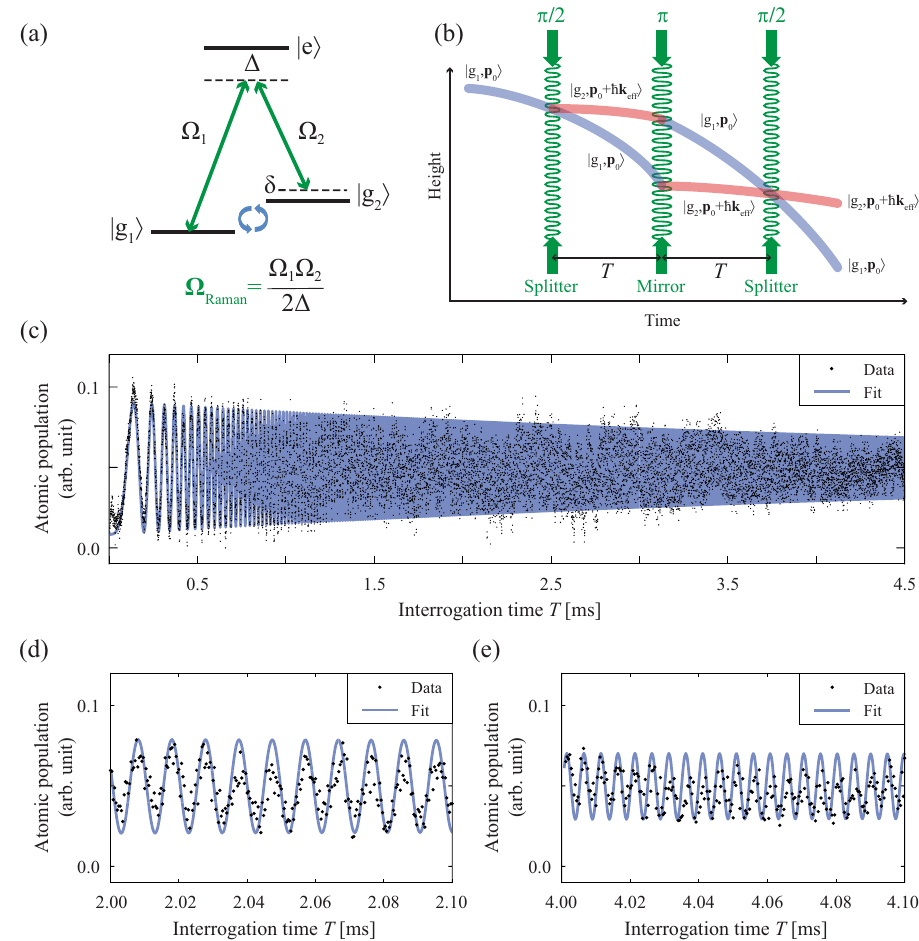
Fig. 8 Atom interferometry of sub-Doppler cooled GMOT atoms in the compact LPAI sensor head. a Three-level atomic system for stimulated Raman (cid:1) (cid:1) (cid:1) (cid:1) (cid:3) (cid:3) (cid:3) (cid:3) (cid:1) (cid:1) (cid:1) (cid:1) ¼ 0 ¼ 0 ¼ F ¼ 1 ; m ¼ F ¼ 2 ; m transitions. g 1 , ground state 1; g 2 ground state 2; e j i , excited state; Δ , single-photon detuning; δ , two-photon (cid:1) (cid:3) F F (cid:1) ! e j i transition; detuning which depends on the Doppler shift; Ω Raman , effective Rabi frequency of Raman beams; Ω 1 , single-photon Rabi frequency of g 1 (cid:1) (cid:3) (cid:1) Ω ! e j i transition. b Space-time trajectory of atomic wavepackets during LPAI. A three-light-pulse sequence, 2 , single-photon Rabi frequency of g 2 π the initial atomic momentum; T , the free-evolution time between Raman pulses; k eff , the effective wavenumber of stimulated Raman transition; k , the wavenumber (2 π / λ ) of a single Raman beam. c Scan of the interrogation time showing the LPAI chirped fringe for T = 0.0 ms to 4.5 ms. The fringe chirping results from the Doppler shift of the cold atoms relative to the Raman beams as the atoms accelerate due to gravity. Each data point in the plot is an (cid:4) average of three data points and a slowly-varying offset was removed. The data is fi t to a chirped sinusoid 92 cos k eff g k T 2 þ τ π ð 1 þ 2 π Þ T the π -pulse duration, g k is gravity, and ϕ 0 is an arbitrary phase factor. We measured g = 9.79316(2)ms − 2 with the statistical uncertainty of Δ g / g = 2.0 × 10 − 6 without vibration isolation. Plots ( d ) and ( e ) provide a detailed view of the chirped fringe of ( c ) for T = 2.0 ms to 2.1 ms and T = 4.0 ms to 4.1 ms, respectively. The measurement data rate is 10 LPAI fringe became chirped as the interrogation time T was increased. Based on the fi t of a chirped sinusoid 41 , we measured g = 9.79316(2) ms − 2 with LPAI operation up to T = 4.5 ms, as shown in Fig. 8c – e. The statistical uncertainty was Δ g / g = 2.0 × 10 − 6 from the fi tting the data for T = 0.0 – 4.5 ms.